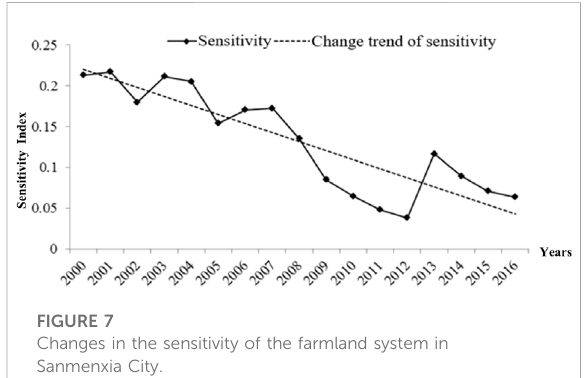
FIGURE 7 Changes in the sensitivity of the farmland system in Sanmenxia City.